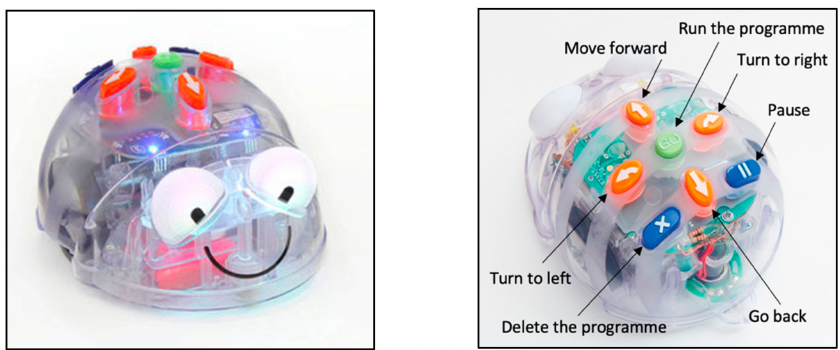
Figure 1. Educative robot used in the implementation.